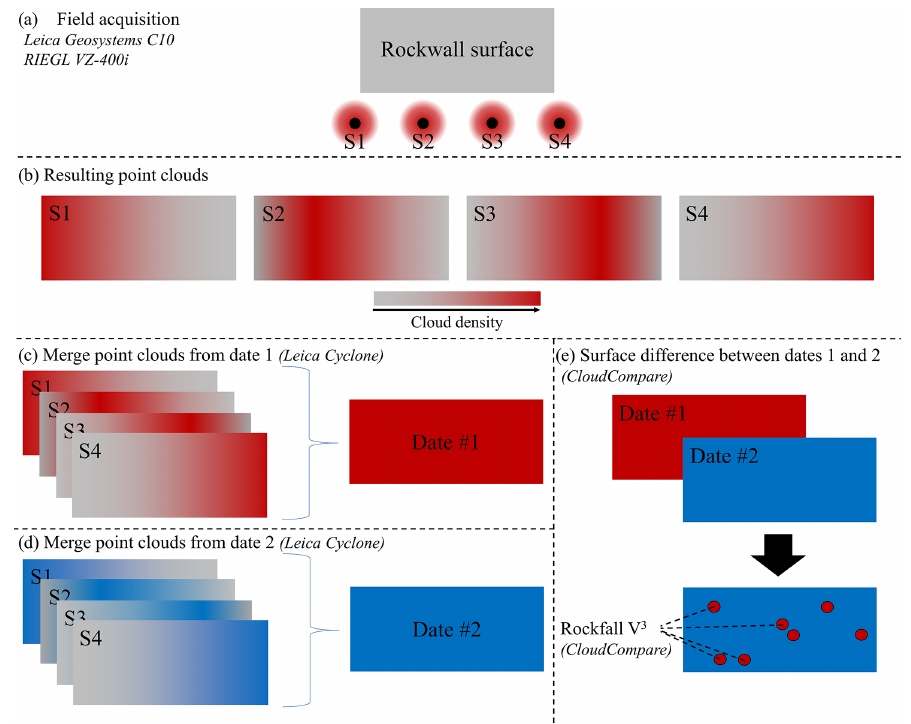
Figure 2. Protocol used to identify and quantify rockfalls from point